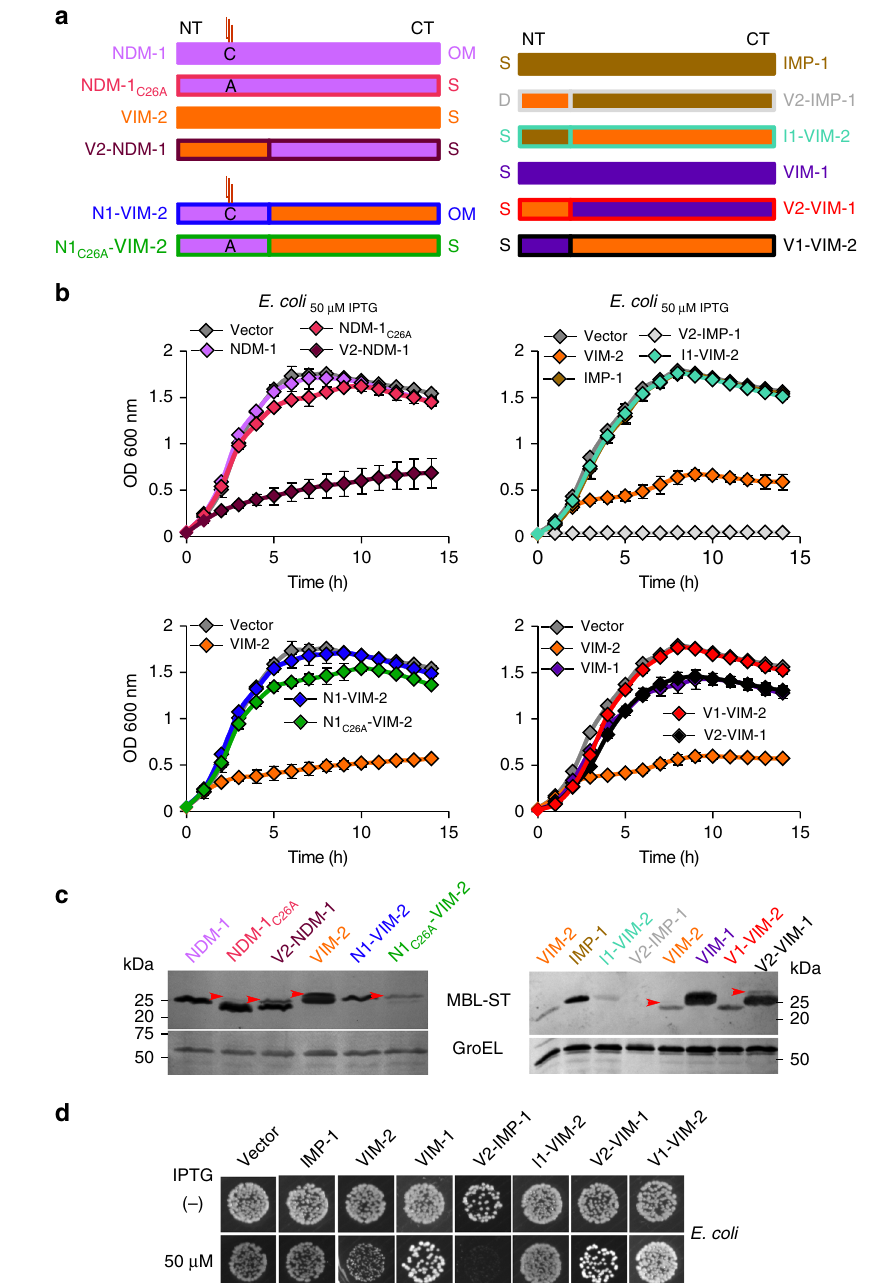
Fig. 4 Impact of cellular localization and protein features of the MBLs on fi tness cost. a Schematic representation of the chimeric MBLs variants with altered cellular localizations and engineered signal peptides. NT : N-terminus and CT : C-terminus. OM : protein lipidated and anchored to outer membrane. S : soluble periplasmic protein. C : cysteine anchoring residue into lipobox sequence. A : alanine residue. By mutation of the cysteine residue by an alanine residue, C26A, the lipidation site is removed resulting in a soluble variant. The same color coding is used for each variant throughout this Figure. b Growth curves of E . coli strains expressing bla NDM-1 or bla VIM-2 with altered cellular localizations in LB at 37 °C with 50 µ M of IPTG ( top and medium panels ). The growth was monitored as above. Data represent the mean value (±s.d) of three independent experiments. Bottom panel : Protein levels of NDM-1, VIM-2 and their chimeras with altered cellular localizations by immunoblotting in whole cells from E . coli expressing each MBL after induction at 20 µ M with IPTG. Red arrows indicate the precursor forms. c Growth curves of E . coli strains expressing bla IMP-1 , bla VIM-2 , and their chimeras with their exchanged signal peptidesI1-VIM-2 and V2-IMP-1 ( top panel ). Growth curves of E . coli strains expressing bla VIM-1 , bla VIM-2 , and their chimeras with their exchanged signal peptides ( medium panel ). Bottom panel shows the protein levels of VIM-2, VIM-1, and their chimeras with their signal peptides swapped, by immunoblot analysis. Lower panels show loading control (GroEL). d Bacterial viability in a spot plating assay. Overnight cultures from E . coli expressing VIM-2, IMP-1, VIM-1, and their chimeras were serially diluted and 10 µ l aliquots spotted onto LB agar without ( − ) or with the addition of 50 µ M of IPTG ( + ). Colonies were allowed to develop for 24 h at 37 °C. Panels c ( bottom panel ) and d are representative of two independent experiments. Source data are provided as a Source Data fi